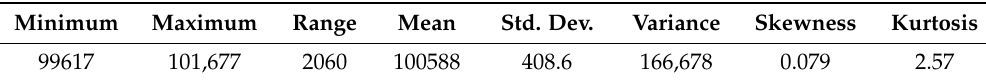
Table B6. Statistics of the inlet water temperature distribution [K].